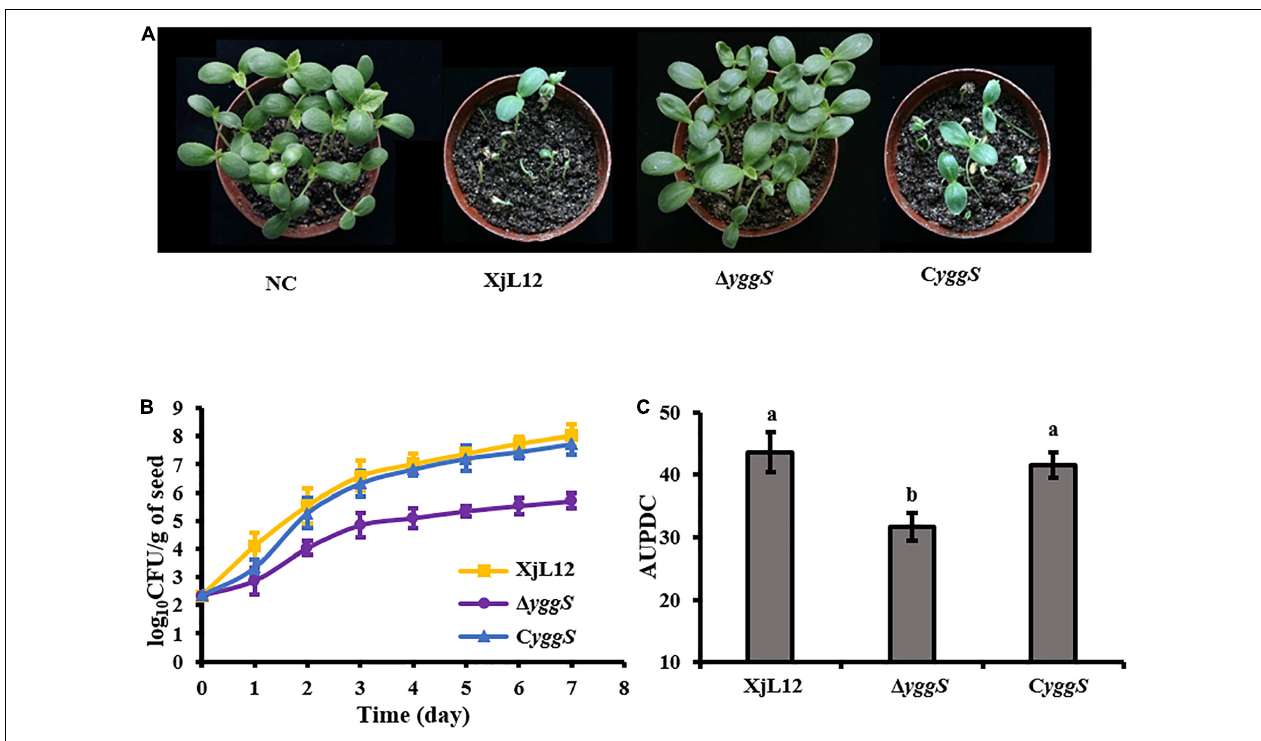
FIGURE 4 | Role of yggS in seed-to-seedling transmission BFB in melon and in colonization in melon seeds by A. citrulli . (A) Effect of yggS on seed-to-seeding transmission of A. citrulli on melon. Melon seeds (n = 20) were innoculated by soaking in bacterial cell suspensions ( ∼ 1 × 10 8 CFU/mL) and then planted. One week after planting, BFB symptoms were observed and photographed. (B) Germinating melon seeds were inoculated with approximately 5 uL of bacterial suspension ( ∼ 1 × 10 5 CFU/mL) and the bacterial populations in seeds were quantified each day for seven days. Each strain was used to inoculate five seeds and each experiment was repeated three times. (C) Histogram of AUPDC calculated bacterial colonization of melon seed. In the graph, the data points represent means and the tines represent the standard errors of the mean. In the histogram, the bars represent means and lines indicate the standard errors of the mean. XjL12: wild-type strain, (cid:49) yggS : yggS deletion mutant; C yggS : complemented strain of (cid:49) yggS . Letters above the bars represent significant differences as determined by the LSD test ( P <